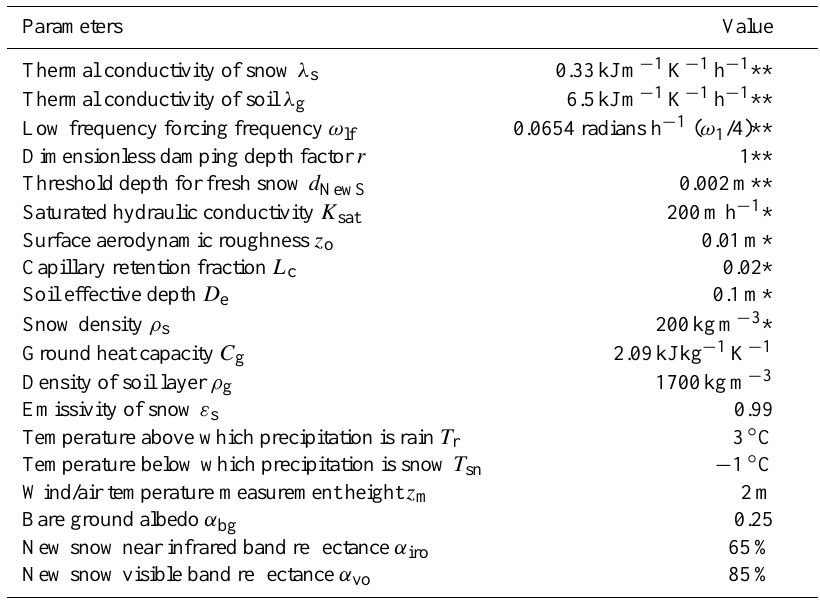
Table 1. Model parameter values.